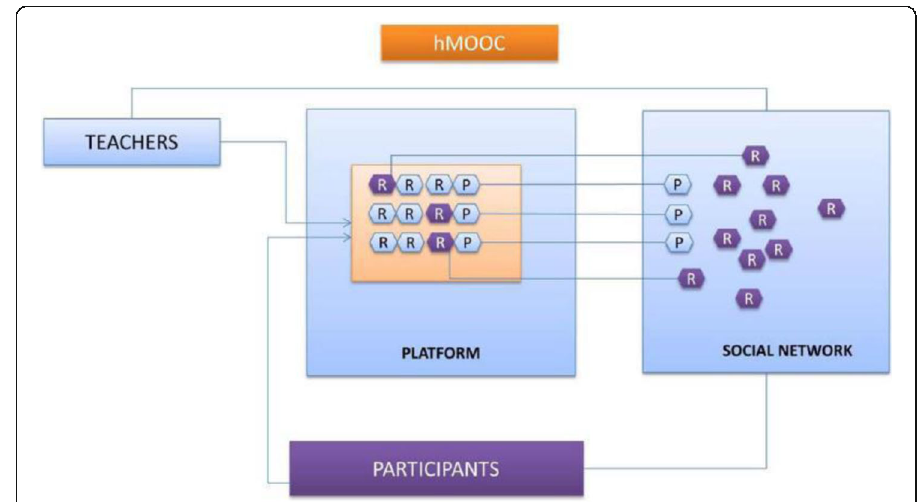
Fig. 1 The structural h-MOOC model (García-Peñalvo, Fidalgo-Blanco, & Sein-Echaluce,